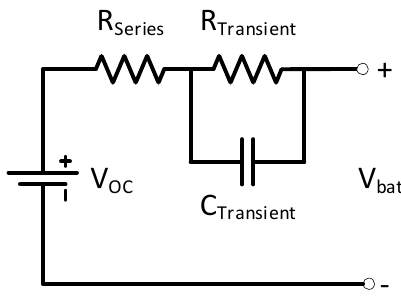
Figure 6. The equivalent model of the battery.